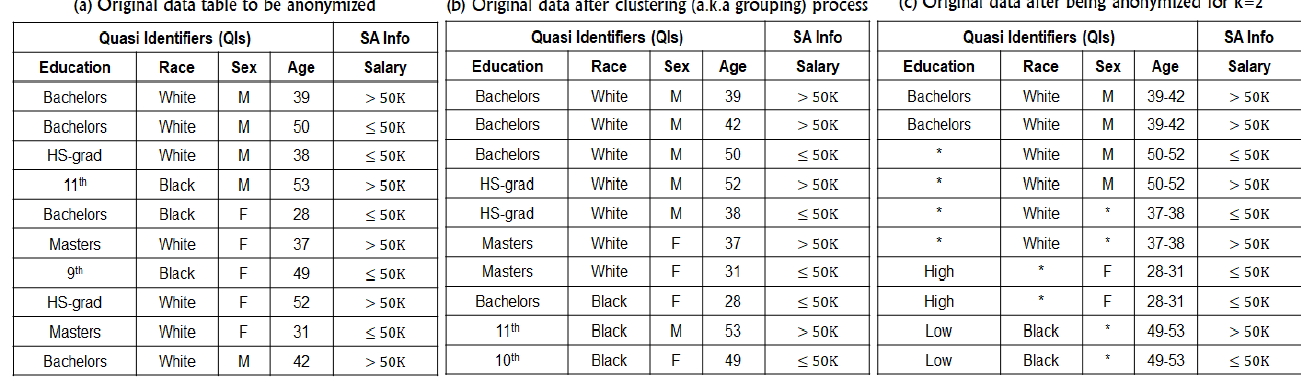
Figure 9. Practical example of personal data anonymization using clustering techniques for achieving 2-anonymity (e.g., k =